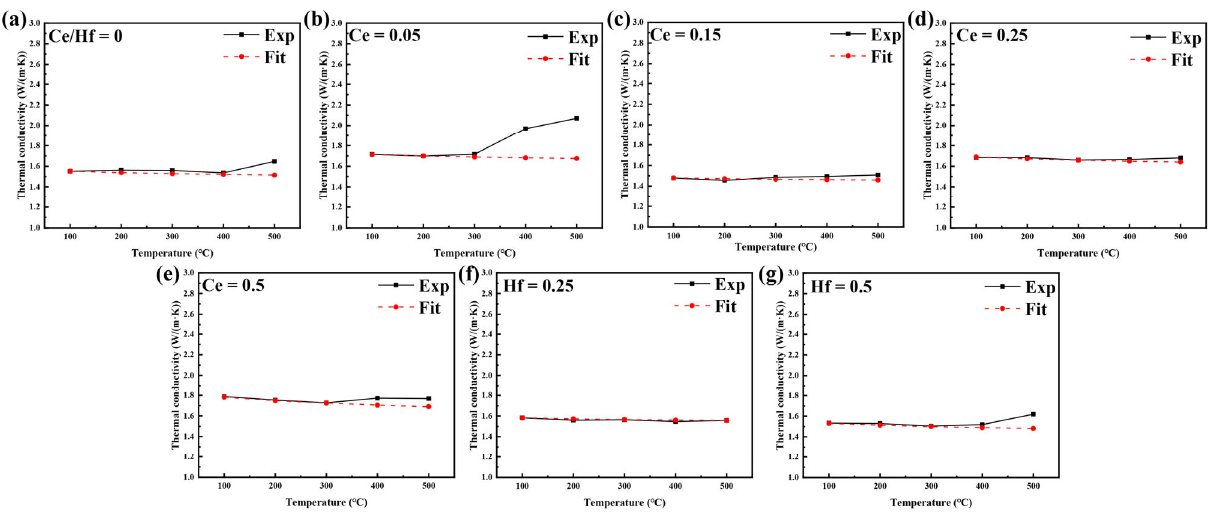
Fig. 9 Experimental and fitting thermal conductivity of A 2 B 2 O 7 high-entropy ceramics. Experimental data at (a, d, f) 100, 200, and 300 and (b, c, e, g) 100, 200, 300, and 400 are selected for fitting. ℃